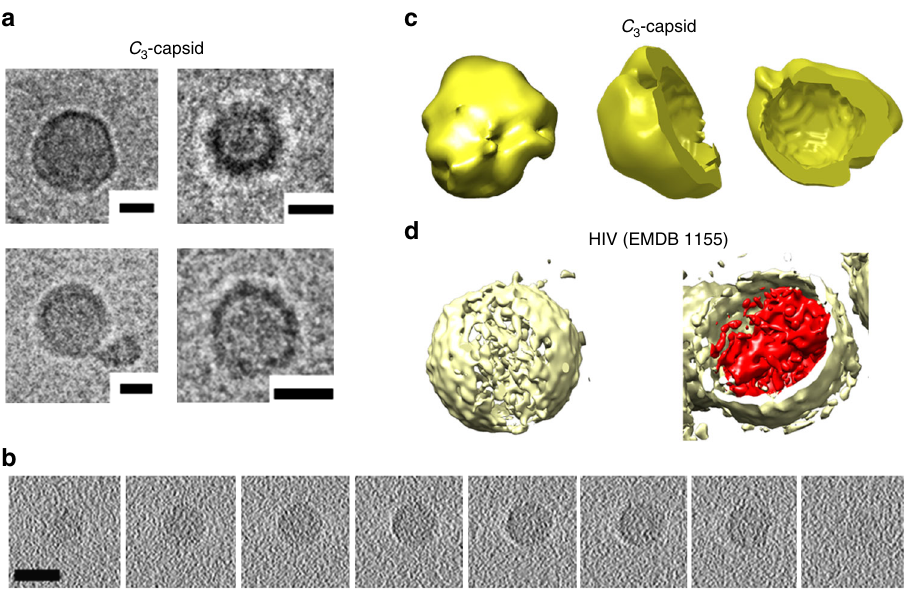
Fig. 4 C 3 -capsids in 3D. a Cryo-electron micrographs of assembled C 3 -capsids. Scale bars are 10 nm. b Representative cryo-electron tomography ( z -planes) for an assembled C 3 -capsid. Scale bar is 20 nm. c 3D rendering of the capsids. Volume reconstruction for a C 3 -capsid is fi tted to a sphere with a radius of 12 nm showing the exterior of the capsid in yellow and its side and top cross-sections. Molecular graphics and analyses were performed using UCSF Chimera package 39 . Chimera is developed by the Resource for Biocomputing, Visualisation and Informatics at the University of California, San Francisco (supported by NIGMS P41-GM103311). d 3D rendering of HIV-1 core shell (EMDataBank entry 1155) shown for comparison. The volume reconstruction, with the exterior and interior shown in yellow and red, respectively. Note: not to scale, HIV particles are > 100 nm in